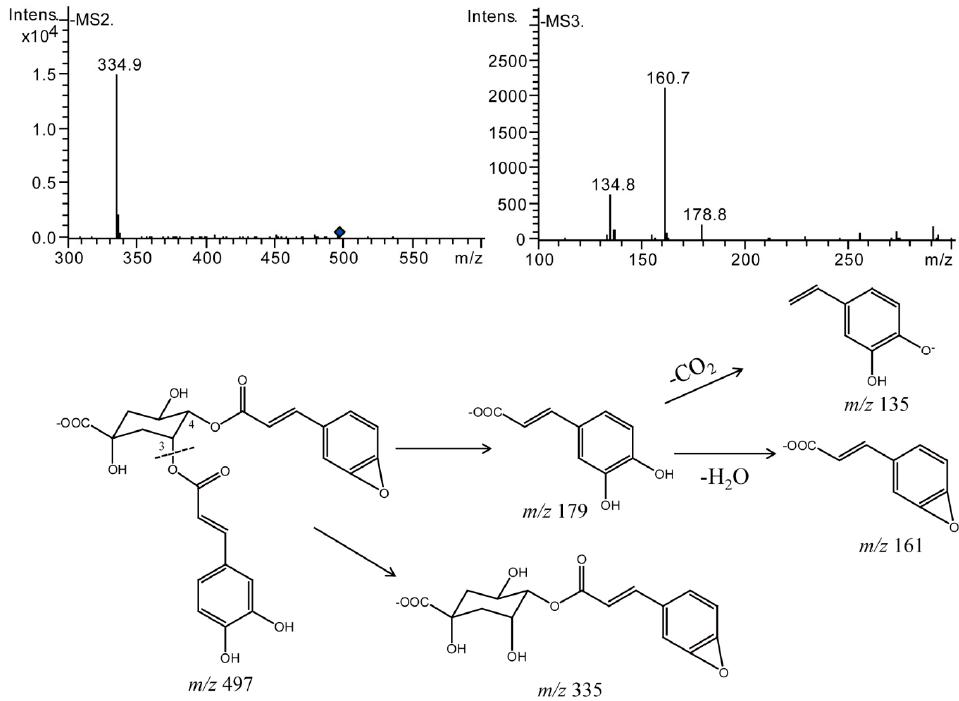
Figure 13. Negative MS n spectra and proposed fragmentation patterns of dehydrated 3,4-diCQA.